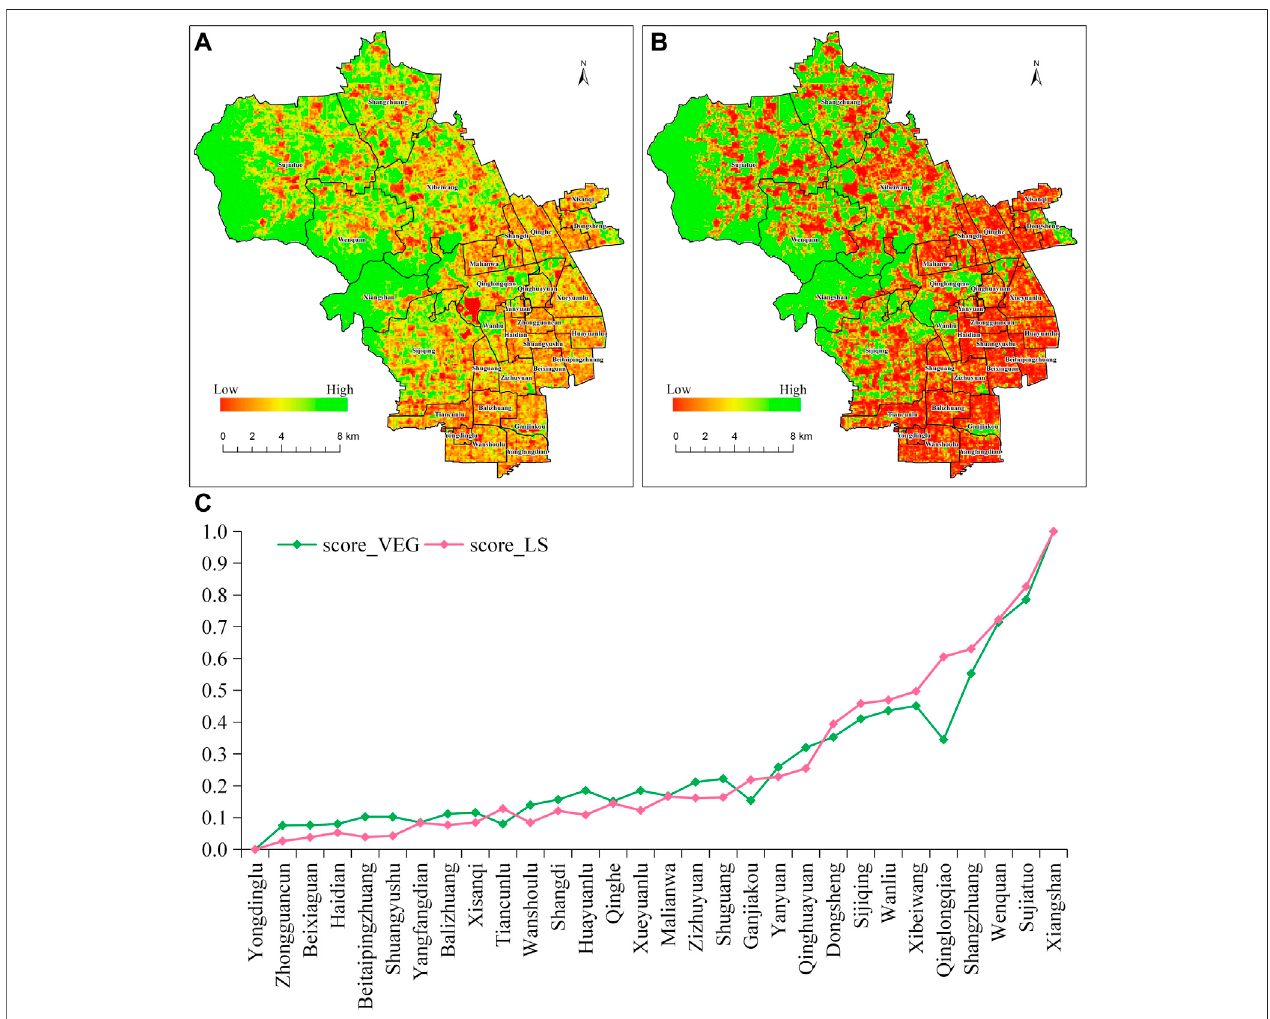
FIGURE 7 | Map of Vegetation condition (A) , Landscape pattern (B) , and the sub-district-wise values in Haidian district (C) .